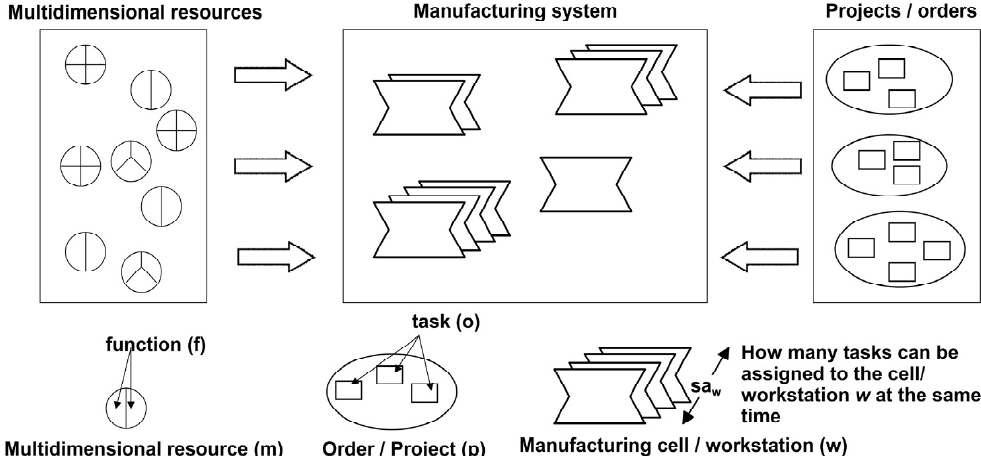
Figure 1. Logical levels in the considered production systems.